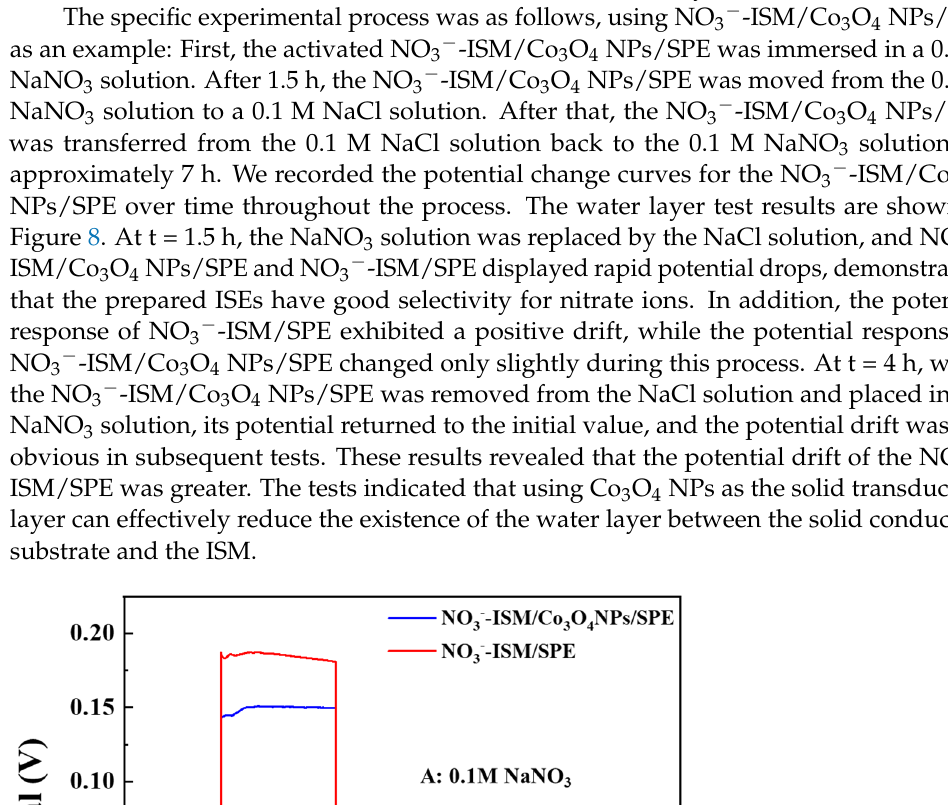
Table 1. Selectivities of the NO 3 − -ISM/SPE and NO 3 − -ISM/Co 3 O 4 NPs/SPE. Interfering Ion Concentration (mg L − 1 )